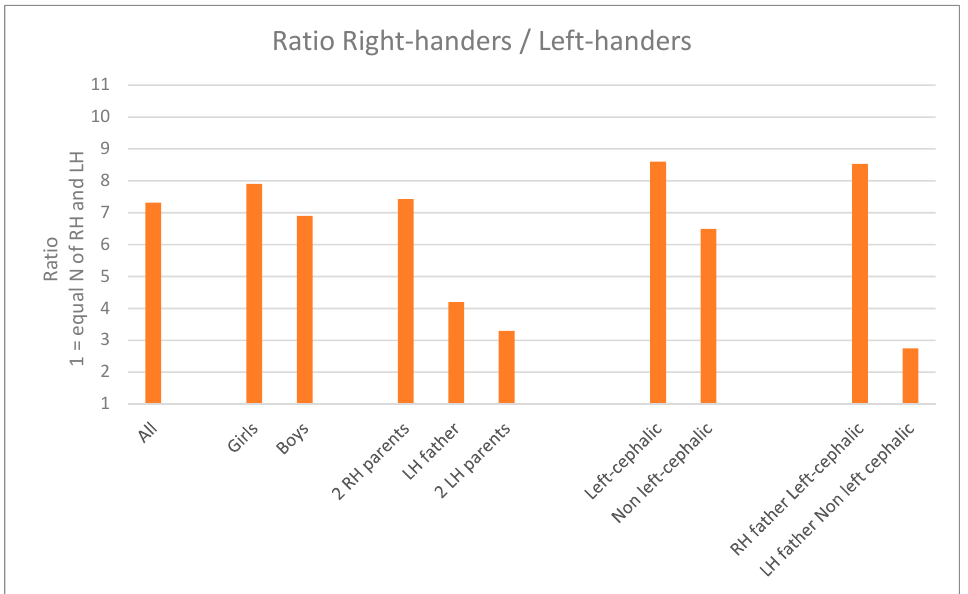
Figure 6. Ratio between the number of right-handers and of left-handers at 5 as a function of the main factors studied ( n = 1123 for all data and for sex; 761, 104 and 13 for parents’ handedness, 508 and 382 for Left-cephalic and Non left-cephalic, and 391 and 30 for RH father Left-cephalic and LH father Non left cephalic). The lowest the ratio, the more equal the number of right-handers and left-handers.